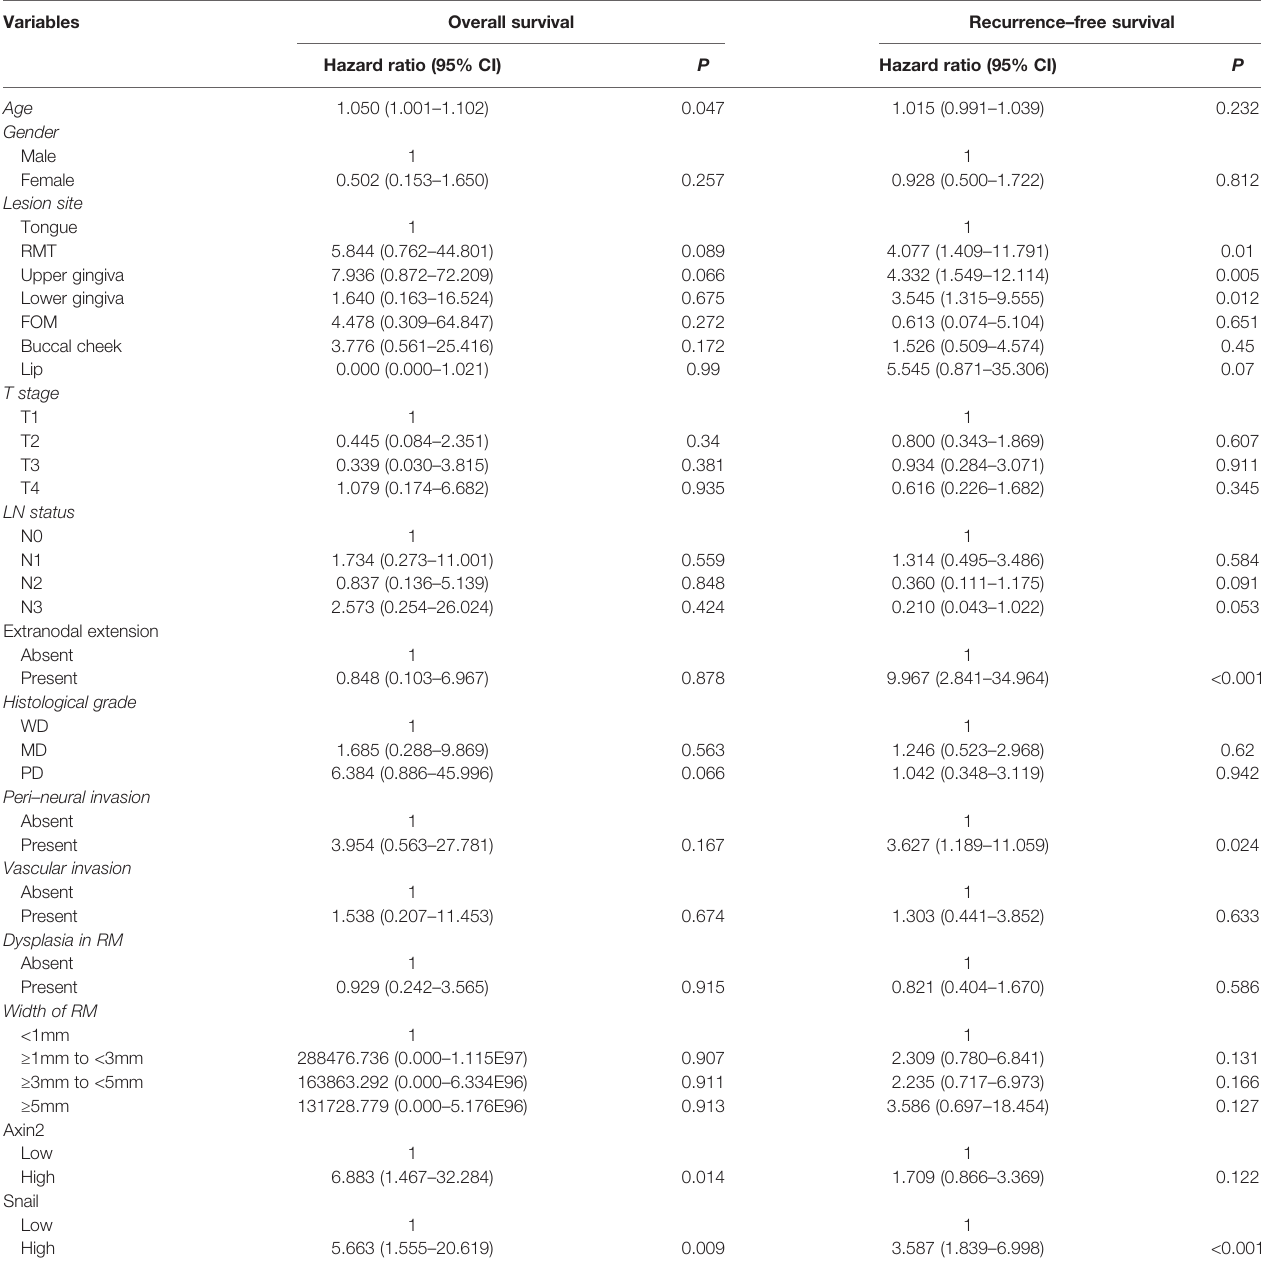
TABLE 3 | Multivariable Cox-regression analysis for risk factors of overall and recurrence-free survival of 235 OSCC